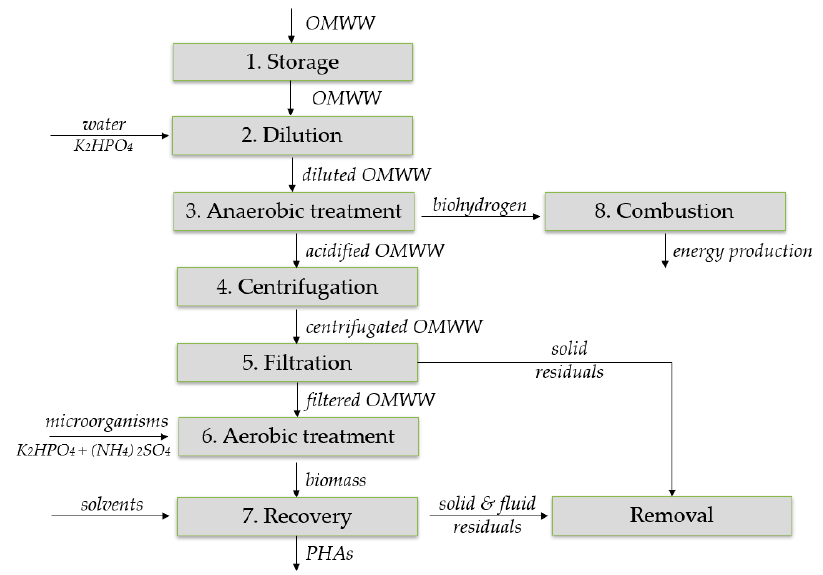
Figure 3. The 9 phases of the production process. Table 4. The planned biorefinery: production process and technical infrastructure (equipment & supplementary